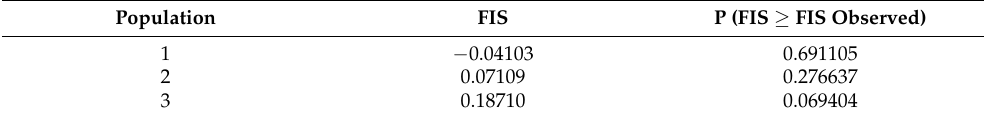
Table 5. Specific FIS indices by population.